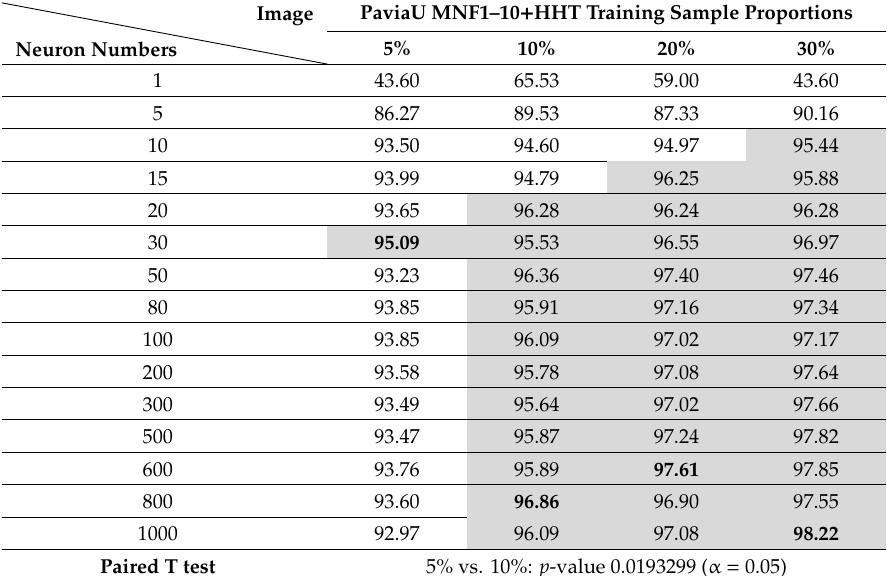
Table 3. Classification accuracy results of PaviaU MNF1–10 + HHT image set with di ff erent training sample proportions using 1 to 1000 neurons. The highest accuracy value in the corresponding training sample proportion column is shown in bold, and values above 95% are shaded in light gray.